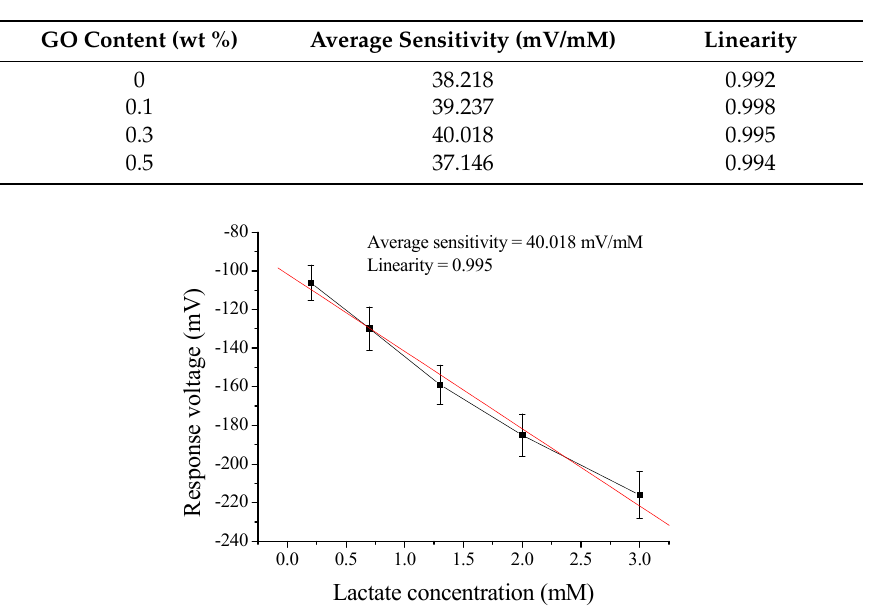
Table 1. The average sensitivity and linearity for flexible arrayed lactate biosensors modified by different graphene oxide (GO) contents.